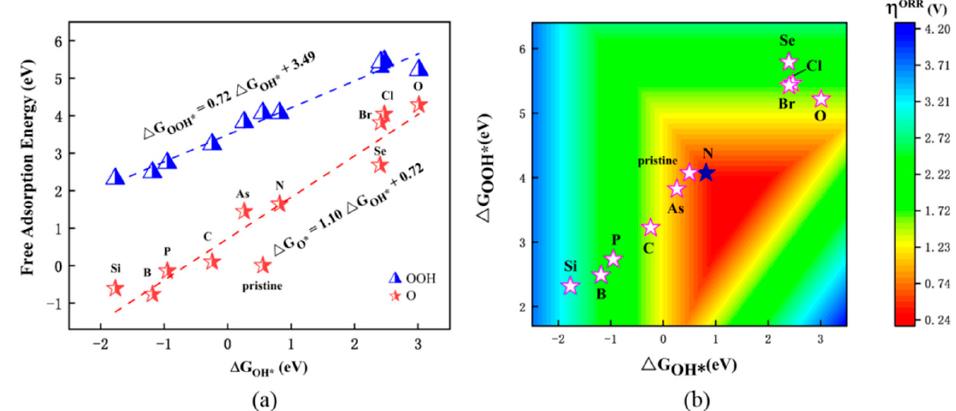
Figure 4. ( a ) Scaling relations between the free adsorption energies of intermediates ( ∆ G O* vs. ∆ G OH* and ∆ G OOH* vs. ∆ G OH* ) and ( b ) η ORR vs. ∆ G OH* on different X@CrS 2 systems.